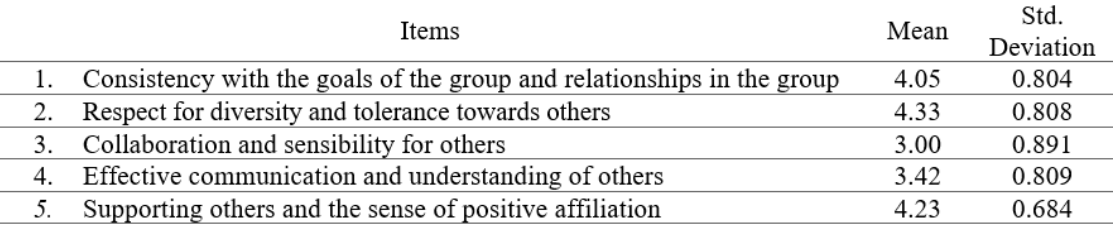
Table 5. Arithmetic mean and standard deviation for five subscales of social